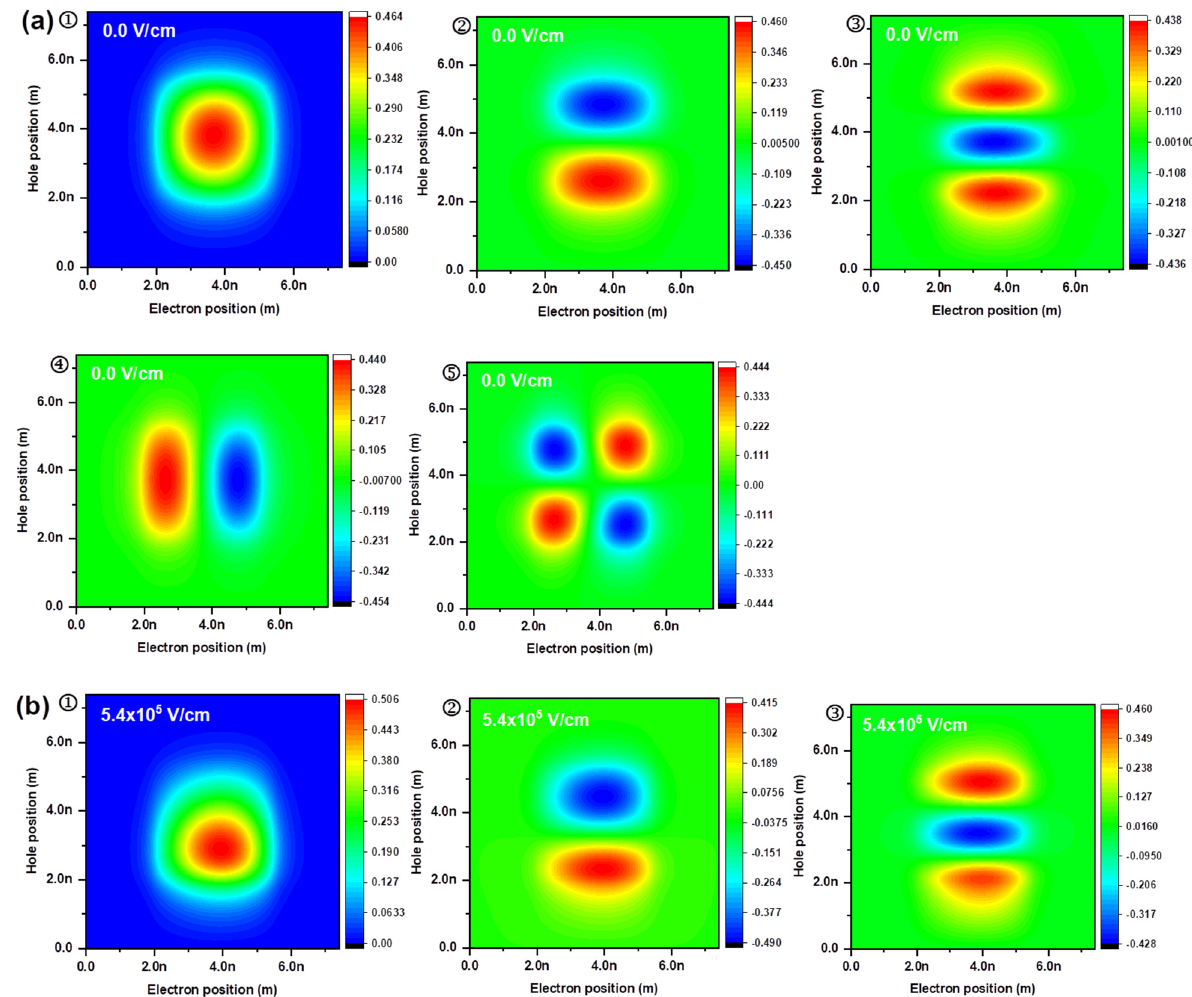
Figure 3. ( a ) Bandgap energy and wavelength as a function of the external electric-field intensity, ( b ) probability densities as a function of the one-dimensional electron–hole distance, and ground state wavefunction distributions as a function of electron and hole positions ( c ) without and ( d ) with external electric field. The legend shows the external electric-field intensity values.